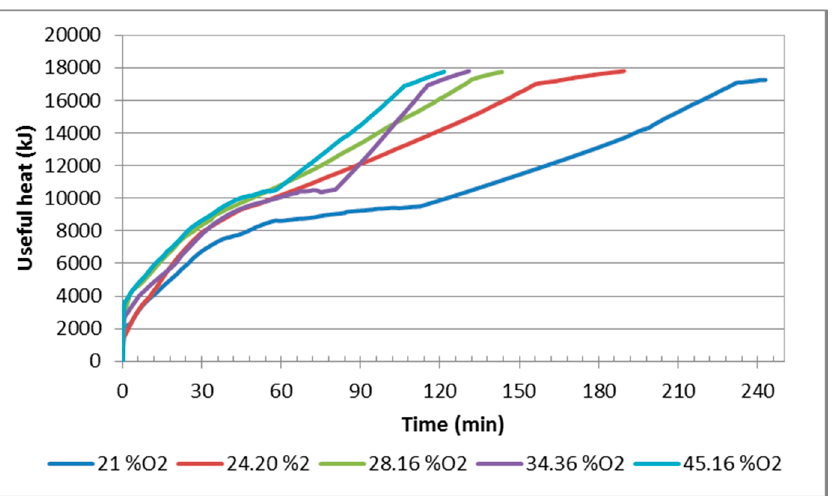
Figure 10. The increase in the specific heat of the charge during the aluminium ingot melting process, related to the change of the oxidizer oxygen concentration using an ordinary air nozzle.